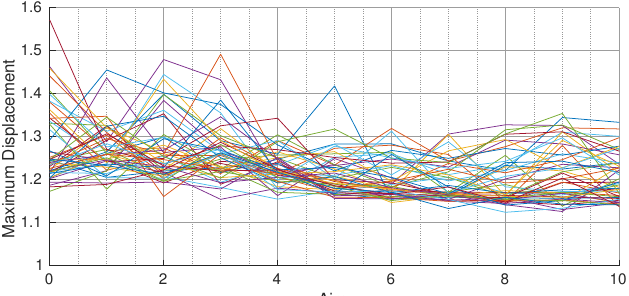
Figure 7. Maximum vibration amplitude for increasing intentional mistuning amplitude for 50 random mistuning patterns. Rotor A, alternate pattern, ξ = 5 × 10 − 4